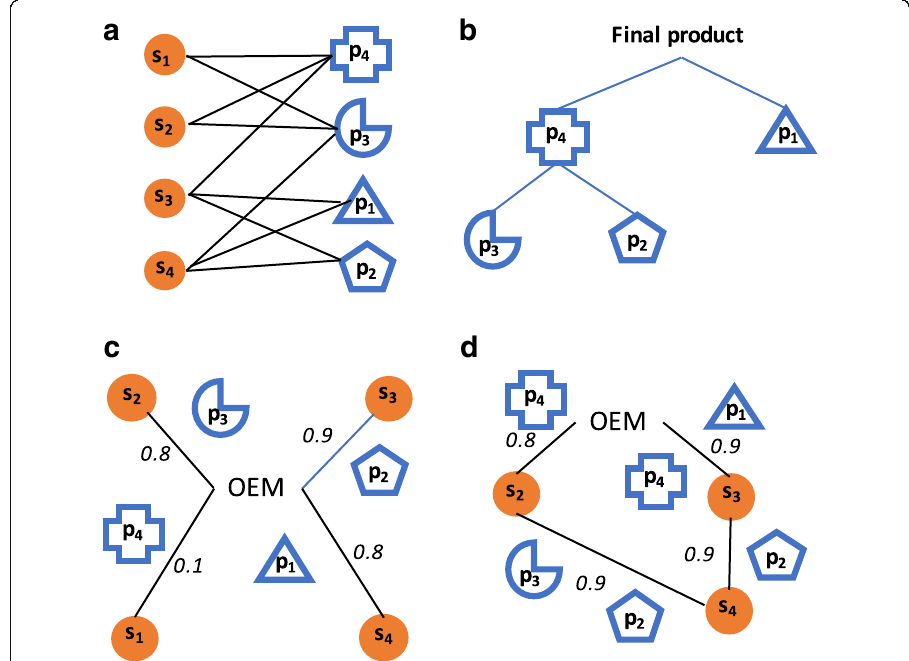
Fig. 2 Illustrative supply chain reconfiguration ( a ) bipartite network of suppliers and products ( b ) final product structure ( c ) initial unreliable network configuration ( d ) more reliable network